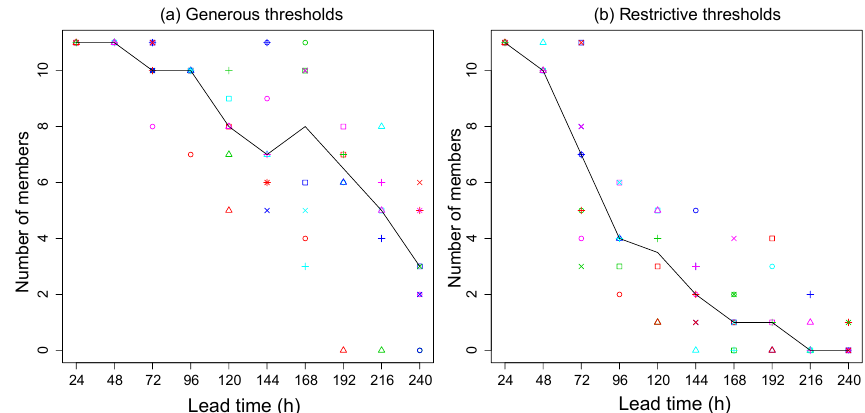
Figure 6. Position and intensity of the storms in the ensemble reforecast as identified and compared on the day of maximum intensity: number of ensemble members predicting the storm within 20hPa and 10 ◦ great circle (a) or 10hPa and 5 ◦ great circle (b) as compared to ERA-Interim in minimum MSLP and position, respectively. The symbols represent the storms as given in Table 1 and the black curve shows the median of the storms per lead